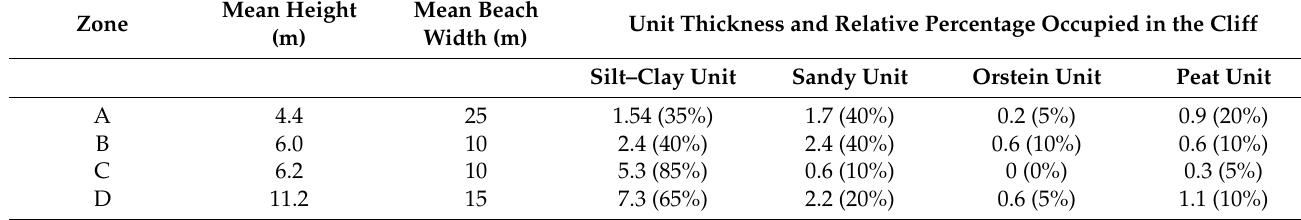
Table 2. Characteristics of each zone.